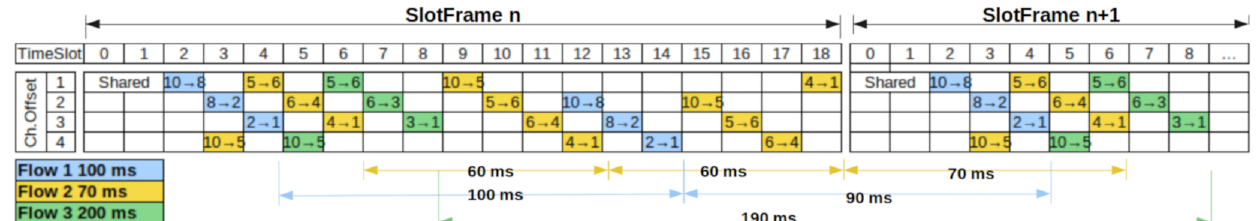
Figure 4. Scheduling flows with different